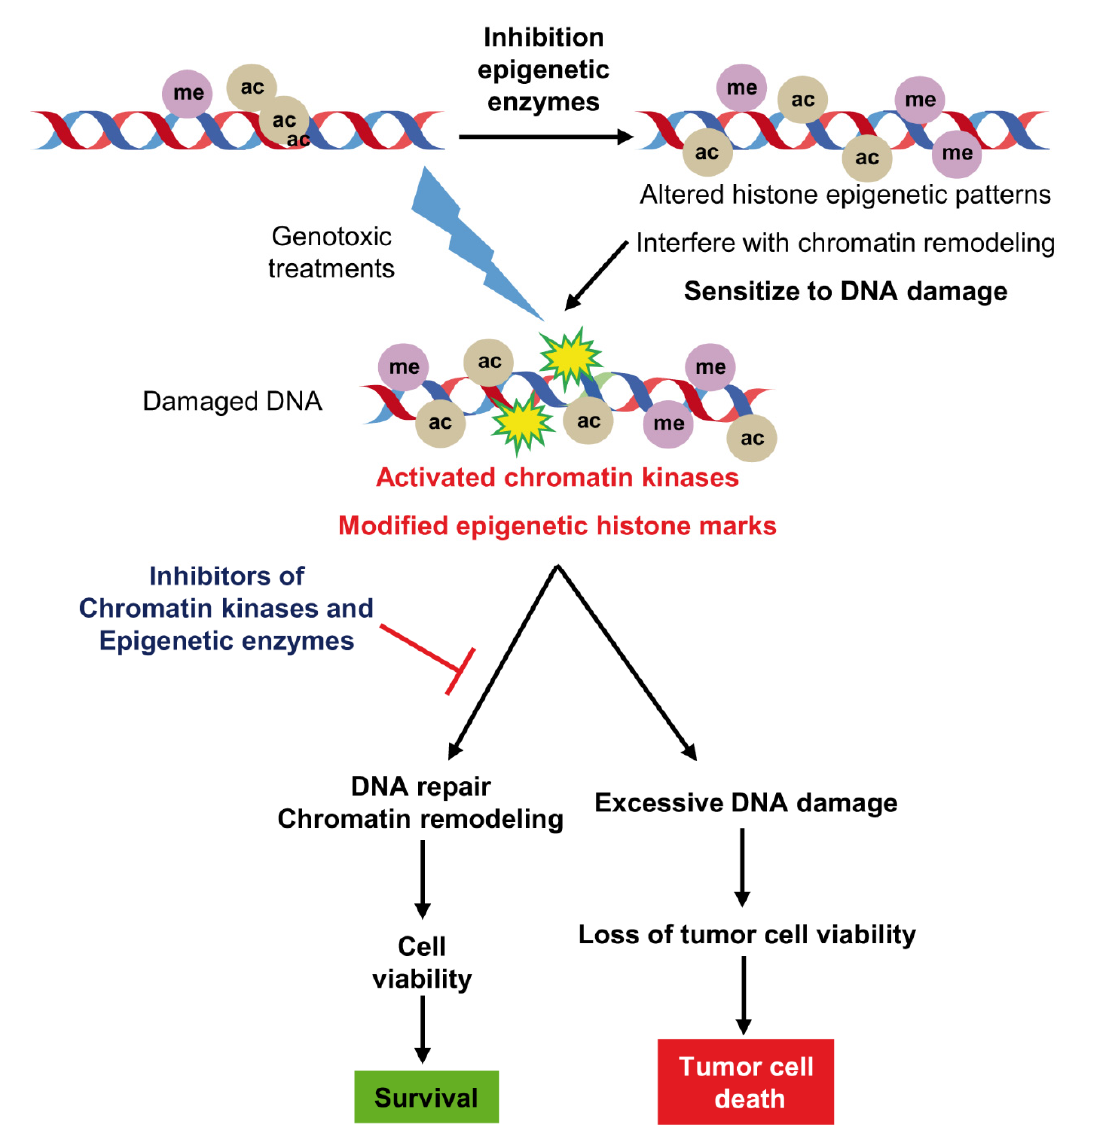
Figure 1. Targeting of the chromatin epigenetic enzymes and nuclear kinases that can modulate the response to therapies based on DNA damage. Inhibition of histone epigenetic modifications cam facilitate DNA damage by facilitating accessorily to DNA genotoxic treatments and by impairing the dynamic chromatin remodeling associated with specific DNA repair mechanisms. ac: acetylation. me: methylation.